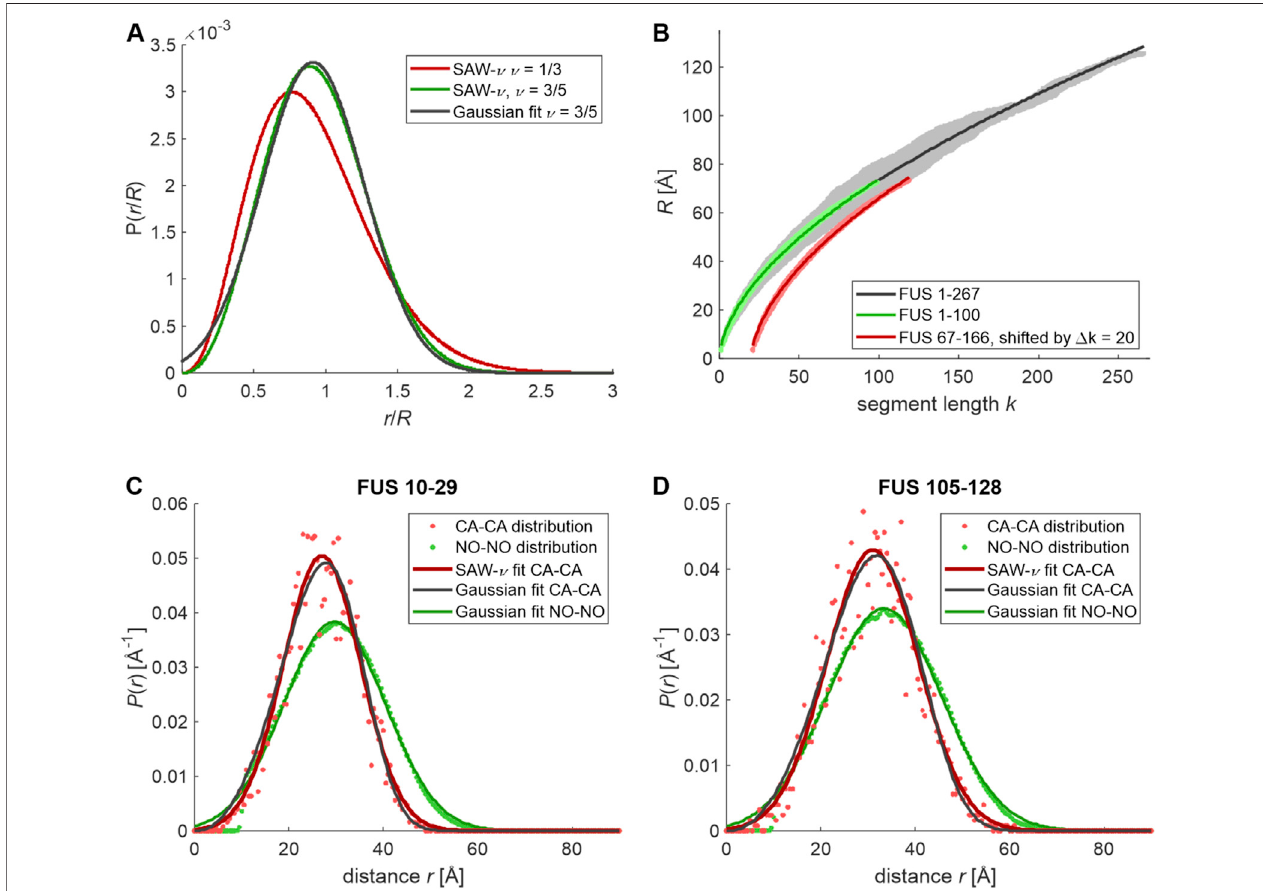
FIGURE1| End-to-end andlabel-to-labeldistancedistributions simulatedfortheunrestrainedNTDofFUS andsections thereof.Residue-speci fi cRamachandran statisticswasassumed asextracted byHovmoller et al.(2002) from PDBforresidues notdenoted ashelixorstrand byDSSP. (A) End-to-end distributionspredictedby the self-avoid walkmodel withvariablescaling exponent(SAW- ν ) byZhenget al.(2018) for apoorsolvent ( ν (cid:1) 1/3,red)and for agoodsolvent( ν (cid:1) 3/5,green)and fi tofa normaldistributiontothegood-solventcase(black). (B) Segment-wiserootmeansquareCA-CAdistancesextracted from90simulatedconformersofFUS1 – 267 (gray),and2,500conformersofFUS1 – 100(lightgreen)andFUS66 – 167(lightred,horizontallyshiftedby20segmentsforclarity)and fi tsbyapowerlaw b · k ν (solidblack, green,andredlines,respectively). (C) CA-CAdistancedistributionforresidues10 – 29in5,000conformersofFUS1 – 100(lightreddots)and fi tsbytheSAW- ν model(red line)andanormaldistribution(blackline)aswellastheMTSL-MTSLdistancedistribution(palegreendots)with fi tbyanormaldistribution(greenline). (D) CA-CAdistance distributionforresidues105 – 128in5,000conformersofFUS67 – 166(lightreddots)and fi tsbytheSAW- ν model(redline)andanormaldistribution(blackline)aswellas